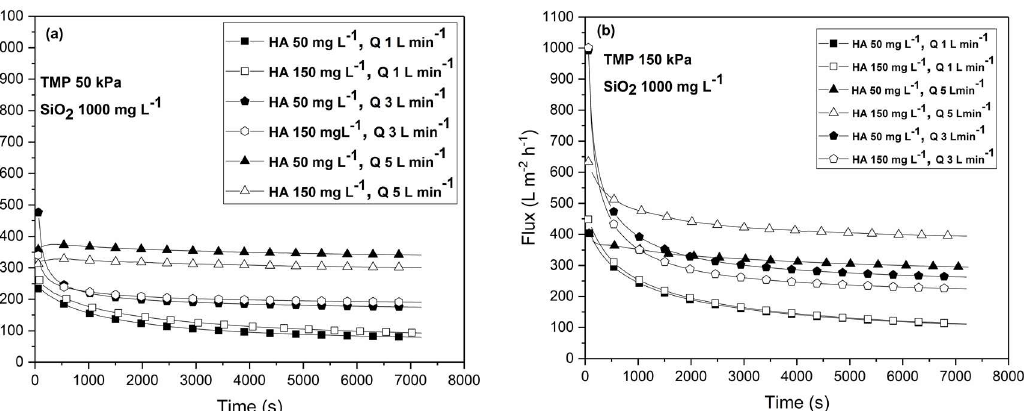
Figure 5. Time dependency of permeate flux under the different operating conditions: ( a ) transmembrane pressure of 50 kPa and ( b ) transmembrane pressure of 150 kPa. The concentrations of humic acid (50 and 150 mg L −1 ) and the cross-flow rates (1, 3, and 5 L min −1 ) are varied. The concentration of colloidal silica was constant (1000 mg L −1 ).